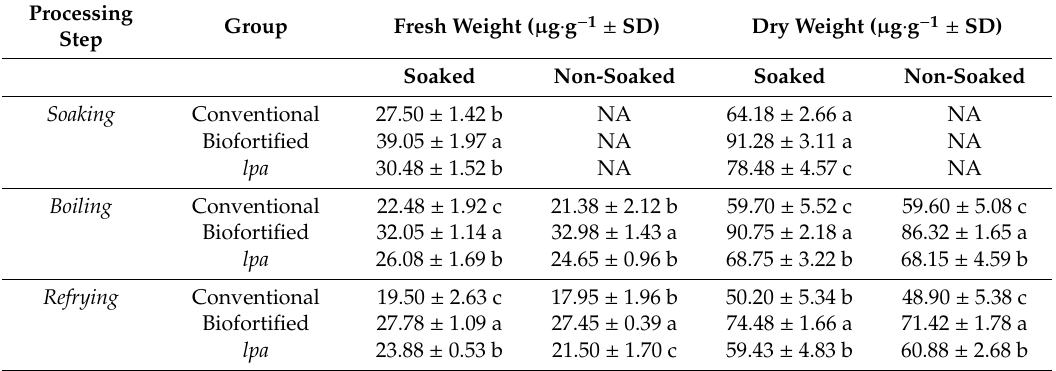
Table A1. Fresh and dry weight ( µ g · g − 1 ± SD) for iron of three groups of beans after five di ff erent processing